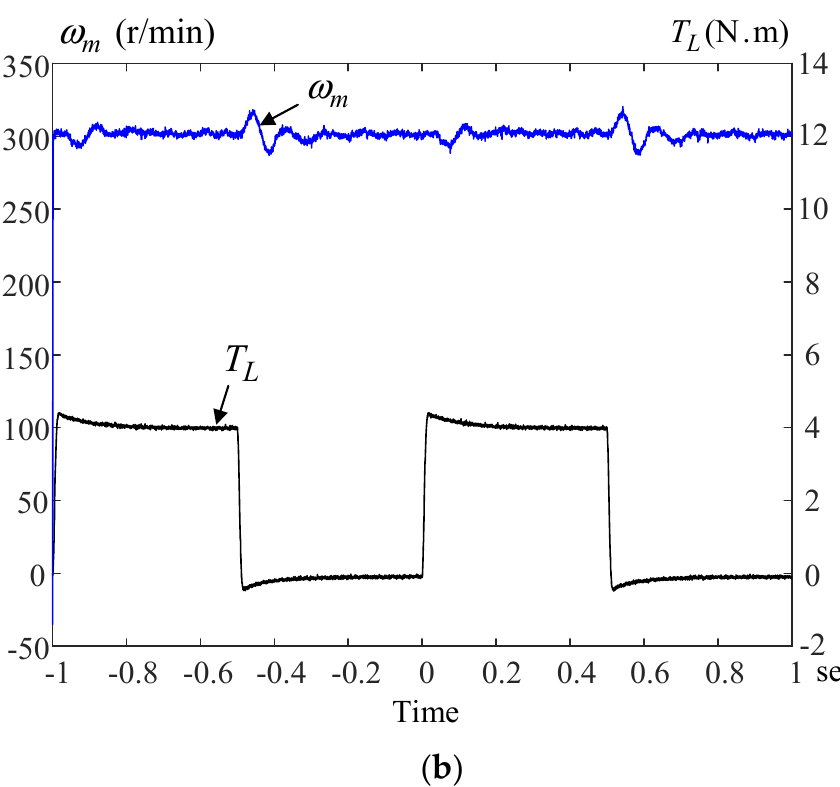
Figure 14. The measured repetitive disturbance responses: ( a ) PI controller; ( b ) CPC.